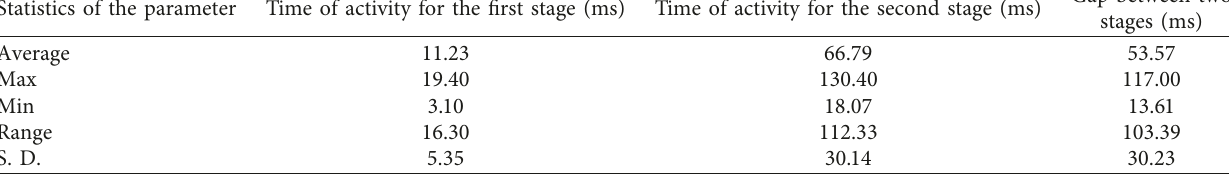
Table 1: Statistics of features of cloud